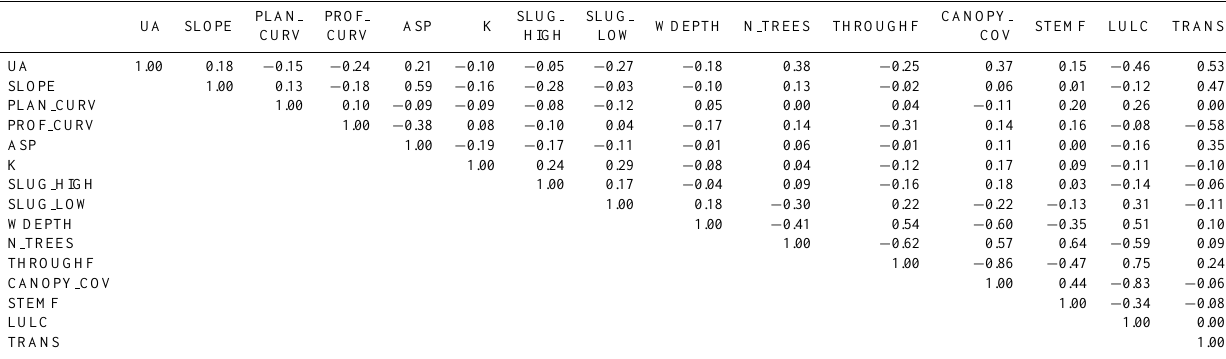
Table 4. Rank partial correlation coefficients (Spearman) between response variable WT NORM and different predictors. Seasonsal scale Event scale Predictors UA